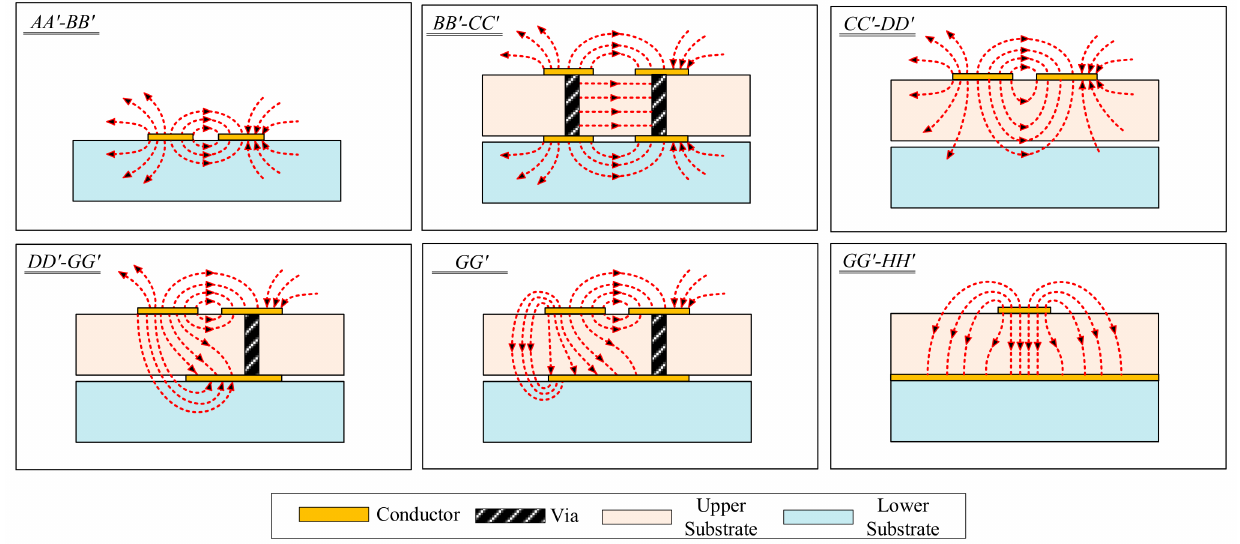
Figure 3. Electric field distributions at several cross-sections along the proposed transition. For a cross-sectional area from AA (cid:48) to BB (cid:48) , the electric field distribution of the con- ventional CPS mode is formed. From BB (cid:48) to CC (cid:48) , two vias are used to connect the top and bottom CPS conductors, and the electric field distribution can be decomposed into a half-plane of the CPS mode in the air for the top conductors, a parallel plate mode between two vias, and a half-plane of the CPS mode for the bottom conductors. The section from CC (cid:48) to DD (cid:48) is a short CPS line on the top side of the upper substrate, and the electric field distribution of the conventional CPS mode is formed. The section from DD (cid:48) to GG (cid:48) is the bended CPS-to-MSL transition, and the electric field lines from the top-side signal conductor to the bottom ground line are formed. The bottom ground line is connected to the top-side ground line through an array of vias, and the width of the ground line is increased from DD (cid:48) to GG (cid:48) . The electric field distribution in this section consists of a half-plane of the CPS mode in the air for the top conductors, a CPS mode with the finite bottom ground line inside the upper substrate, and a fringing field mode distributed through two substrates. However, as the linewidth of the ground plane of the bottom conductor becomes larger, the electric field lines under the top-side conductor are